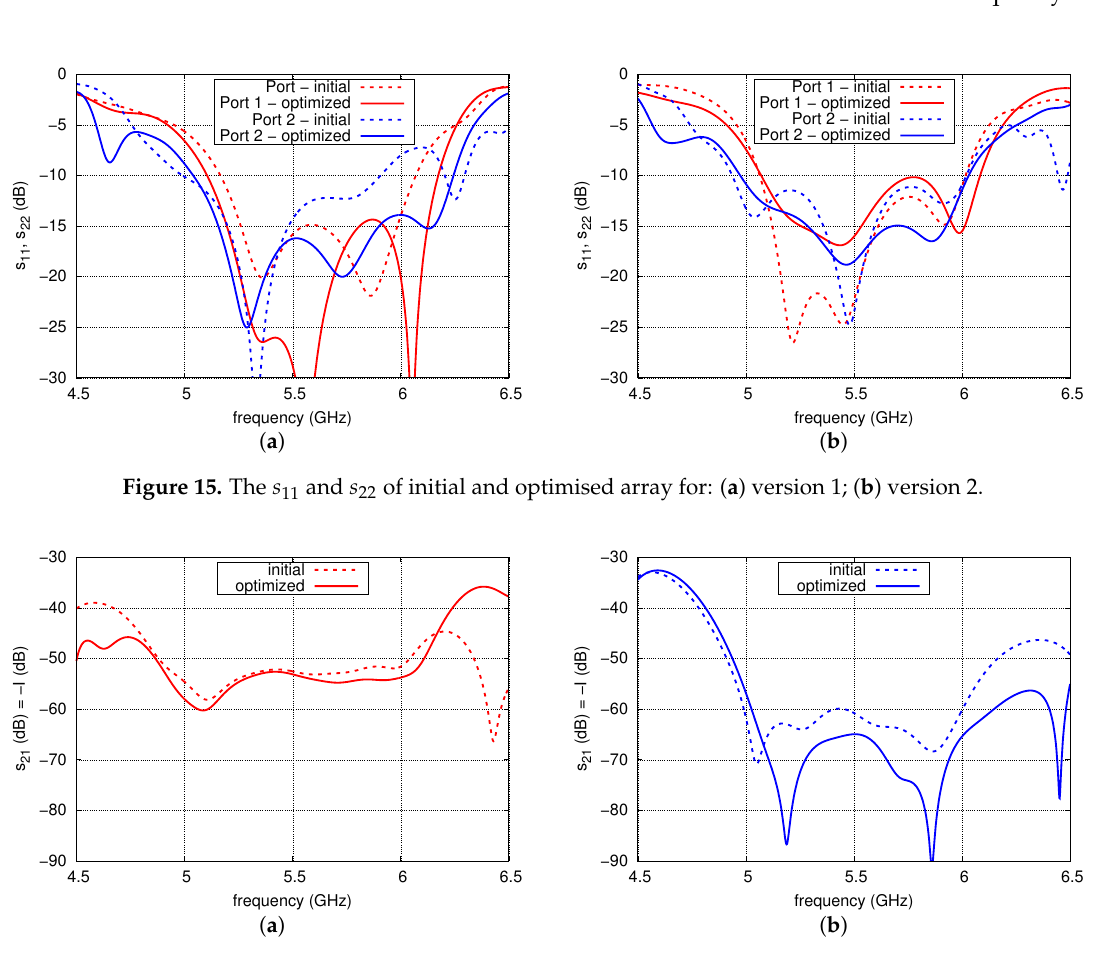
Figure 16. The s 21 of initial and optimised array for: ( a ) version 1; ( b ) version